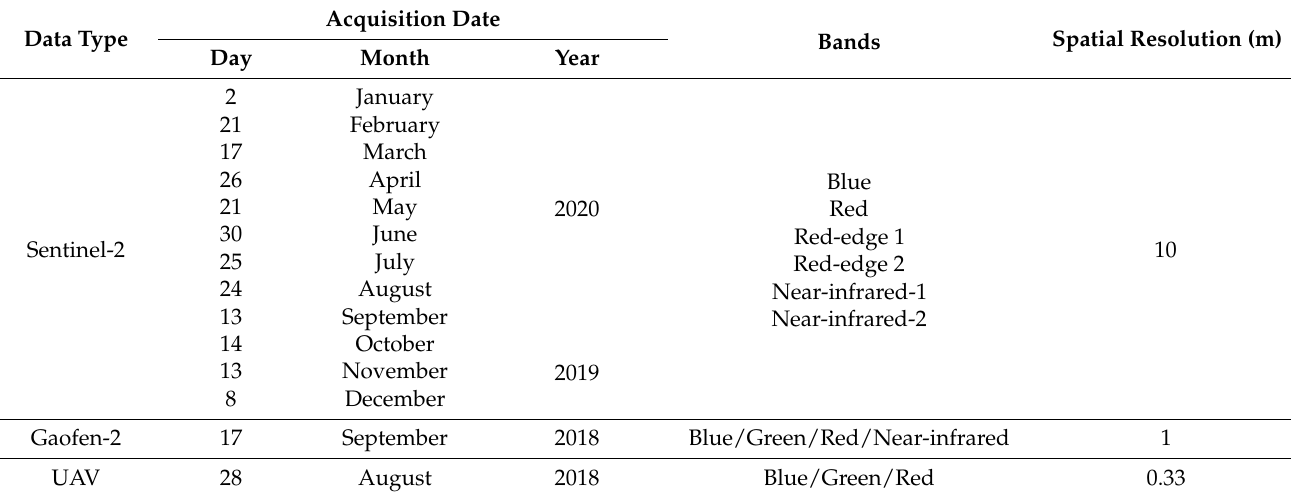
Table 1. Description of the images and bands used in the